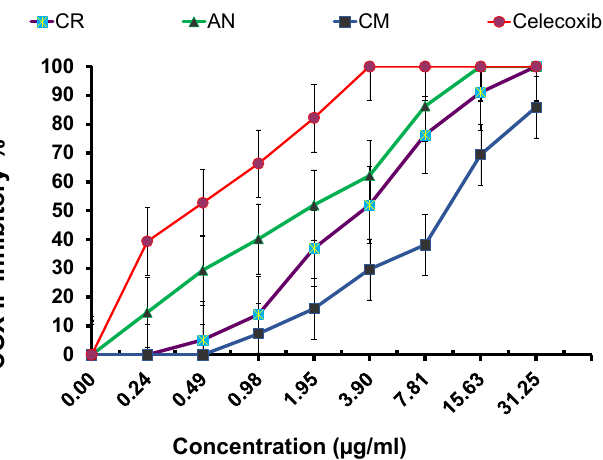
Figure 3. Anti-inflammatory activity cyclooxygenase COX-2 inhibitory % of CM ( C. cyminum ), AN Figure 3. Anti ‐ inflammatory activity cyclooxygenase COX ‐ 2 inhibitory % of CM ( C. cyminum ), AN ( P. anisum ), and CR ( C. carvi ) compared to standard drug, ( P. anisum), and CR ( C. carvi ) compared to standard drug, celecoxib .